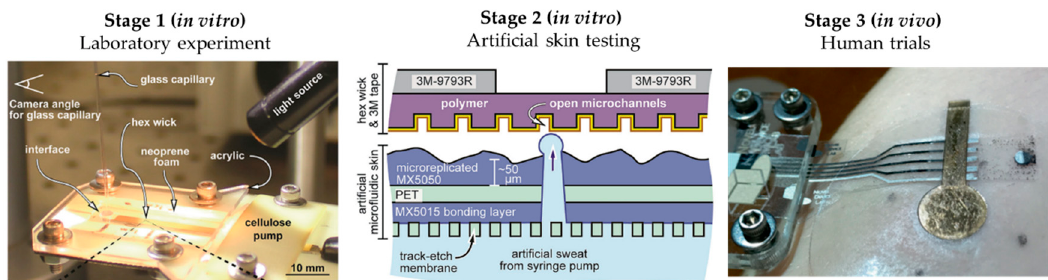
Figure 5. Workflow proposed for microfluidic sweat wearable characterization, using Twine et al.’s [54] work as an example. Initial laboratory experiments (Stage 1) for proof-of-concept, followed by the use of artificial skin (Stage 2) for more realistic in vitro testing for device optimization prior to human trials (Stage 3) for final validation. Adapted with permission from [54]. Copyright 2018, Royal Society of